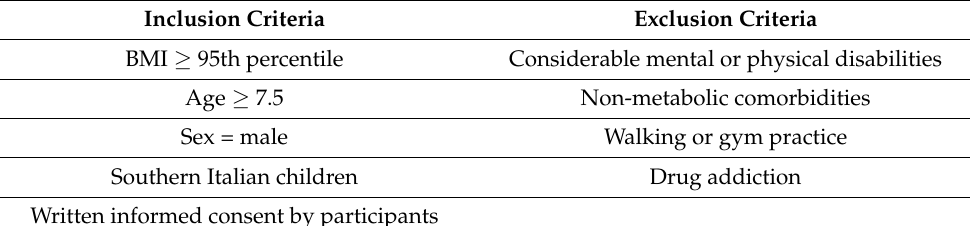
Table 1. Inclusion and exclusion criteria.